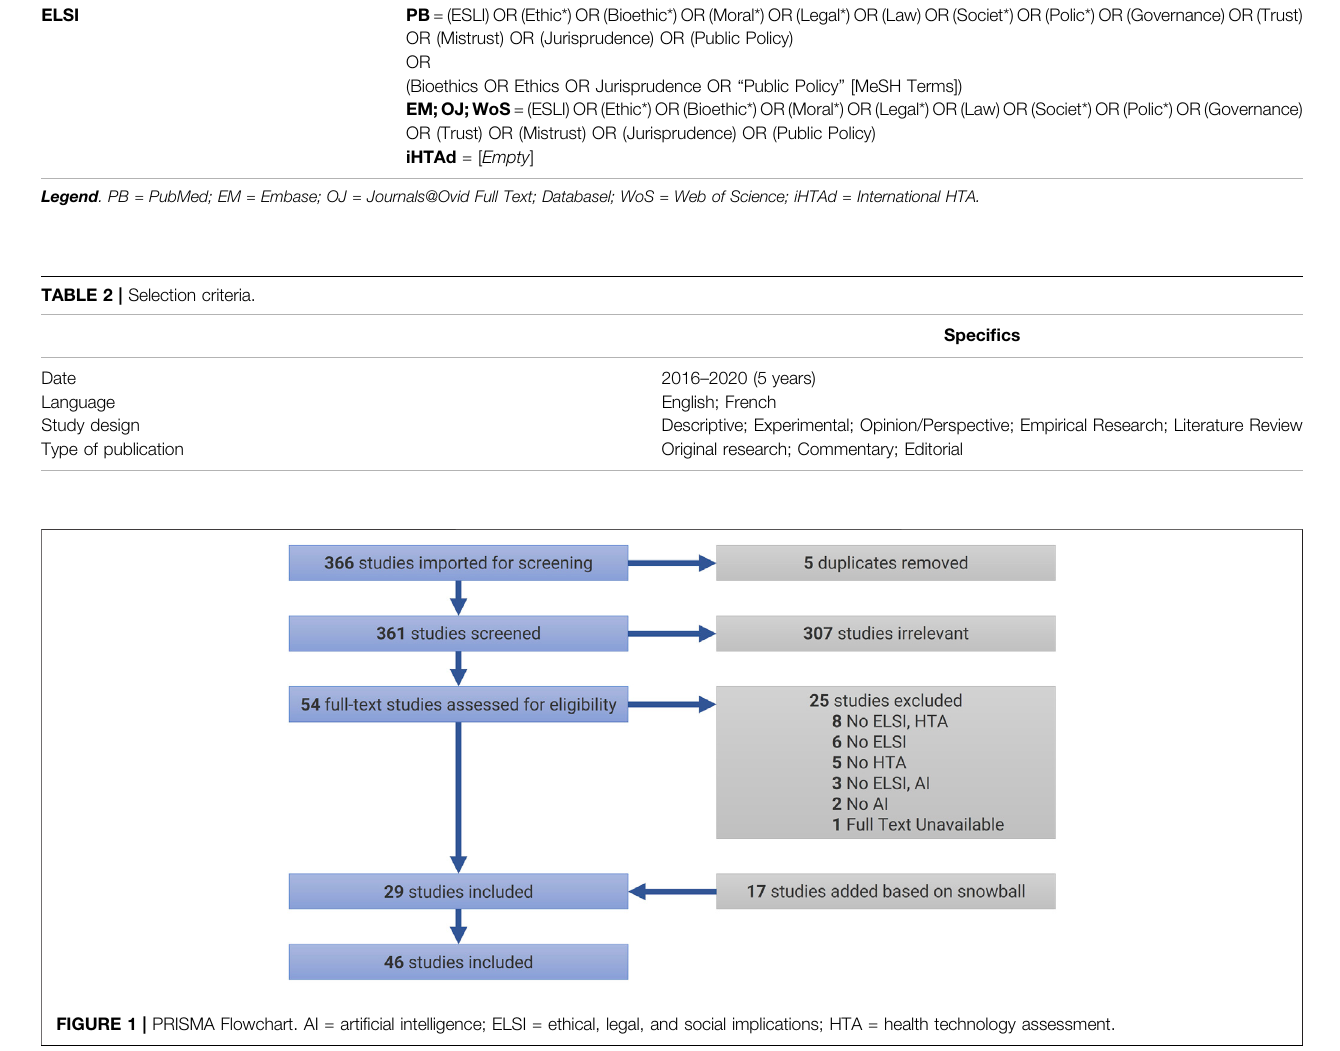
Table 1 ) to identify and collect articles that mention using or discussing AIHTs. The construction of the research strategy and the choice of equations was supported by librarians.